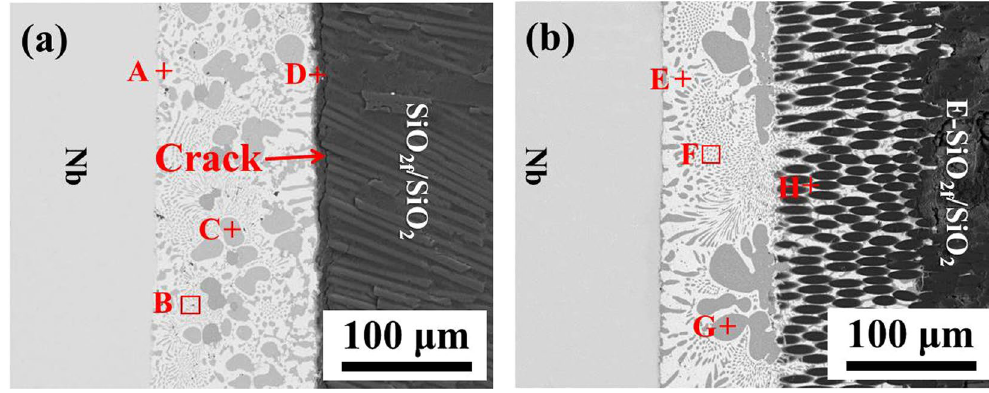
Figure 2. SEM images of ( a ) SiO 2f /SiO 2 -Nb and ( b ) E-SiO 2f /SiO 2 -Nb